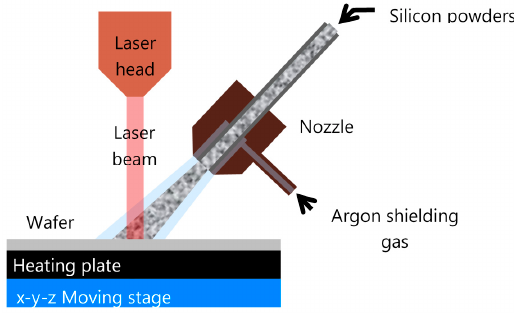
Figure 1. Schematic description of the process [9].